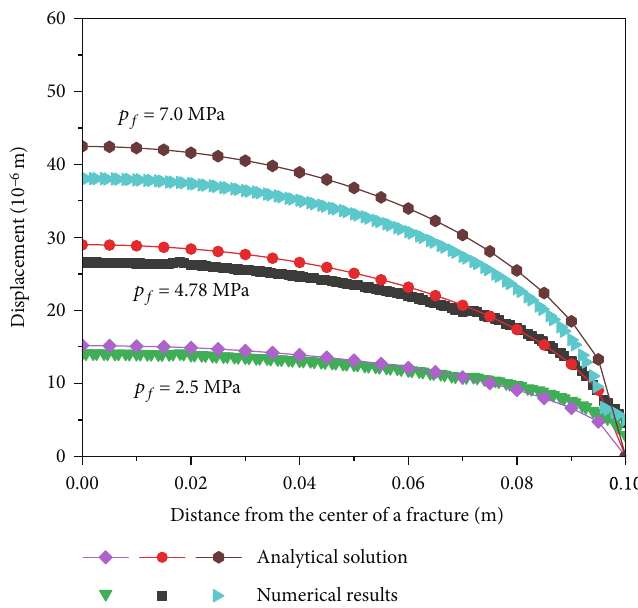
Figure 5: Comparison of numerical and analytical results in displacement along the initial fracture.